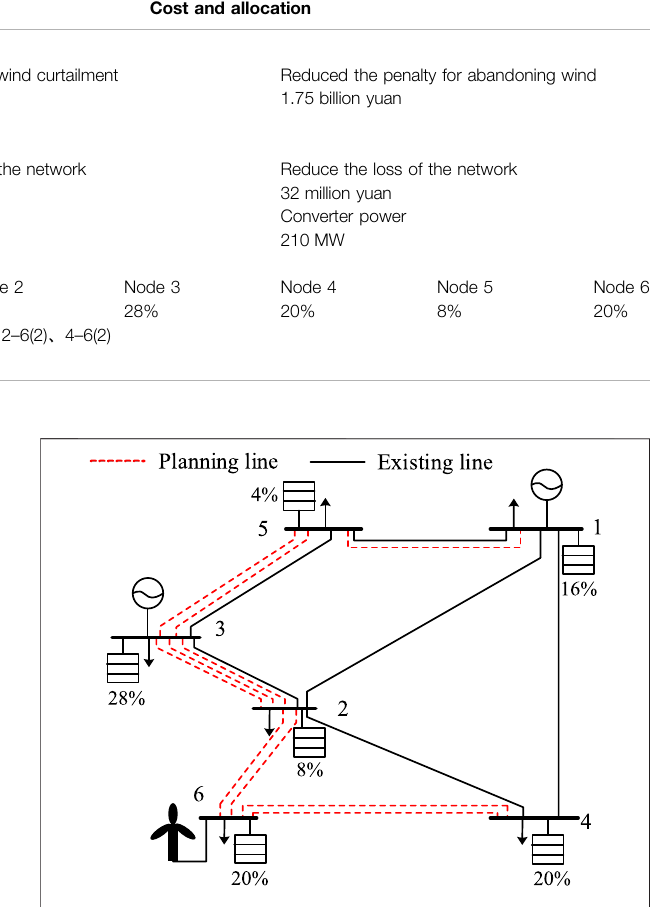
FIGURE 6 | Power grid planning scheme under power